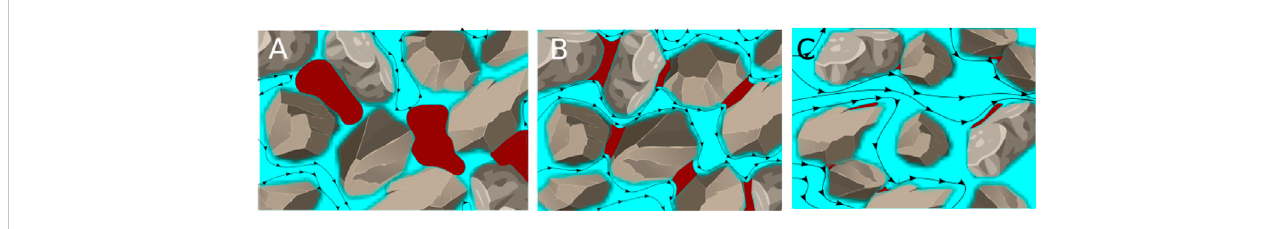
FIGURE 1 Sketch of potential types of capillary entrapmentsfor water wet grains (A) , intermediate wet grains (B) , and oil wet grains (C) . The invading water phase is colored blue, whereas the defending oil phase is colored red. The arrows indicate the path lines of the invading fl uid.